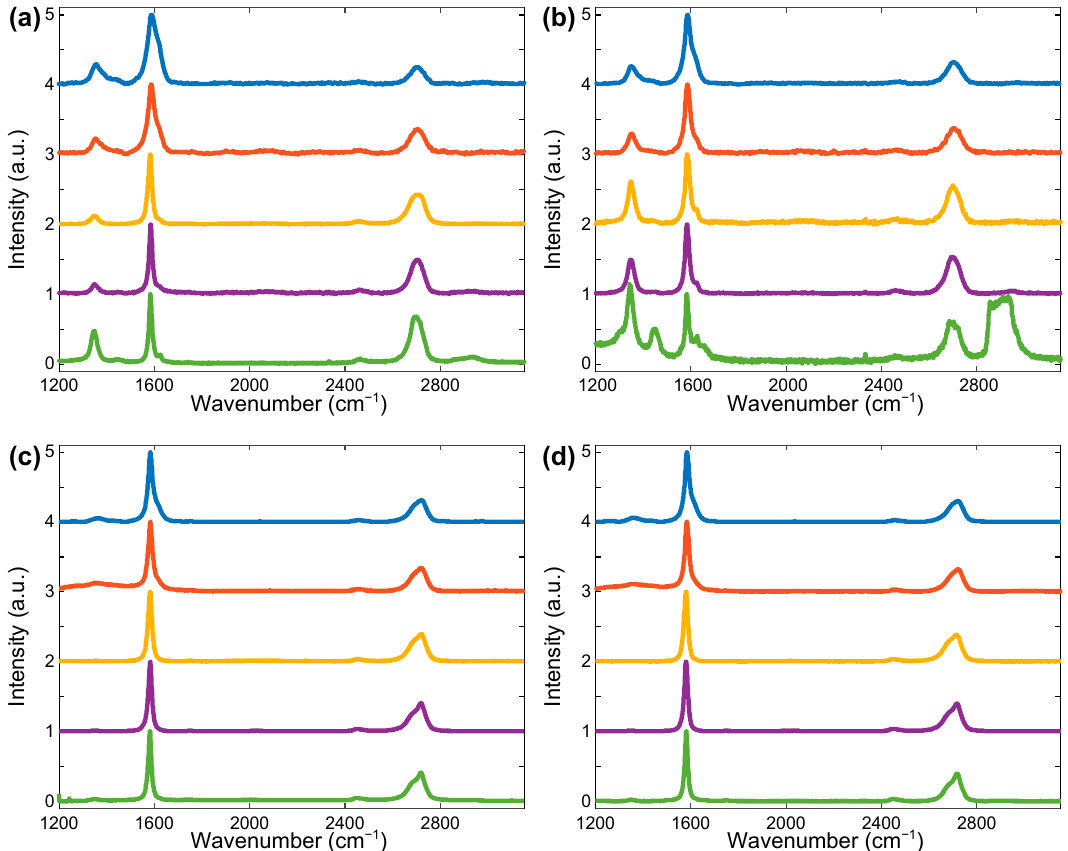
Figure 2. Raman spectra of ( a ) location 1: thin, on substrate; ( b ) location 2: thin, suspended; ( c ) location 3: thick, on substrate; ( d ) location 4: thick, suspended. Spectra are offset vertically by increasing the temperature from bottom to top, before annealing and after annealing at 200, 300, 400, and 500 °C, respectively. Spectra are normalized by the G band intensity.